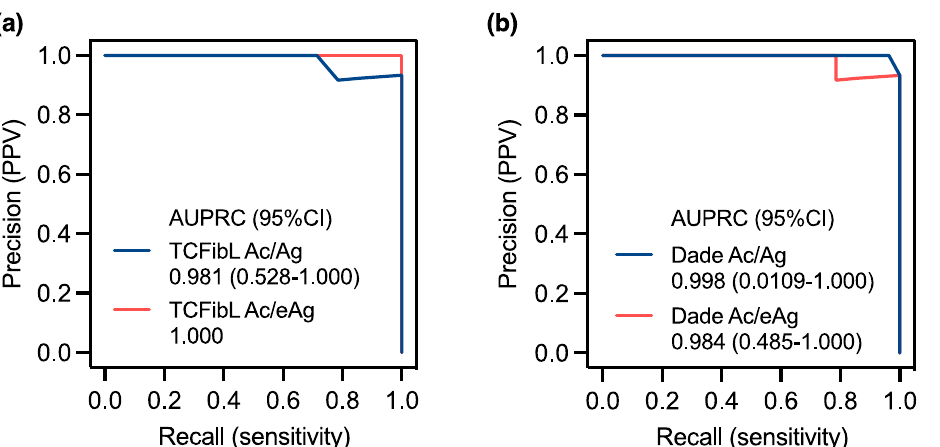
Figure 3. Precision–recall curve analysis. Precision–recall (PR) curves in TCFibL ( a ) and Dade ( b ) reagents. The X-axis represents the recall (sensitivity) and the Y-axis represents precision (positive predictive value [PPV]). The blue solid line shows the results for Ac/Ag ratio and the rose-colored line shows the results for Ac/ eAg ratio. The number represents the area under the PR curve (AUPRC) with 95% confidence interval